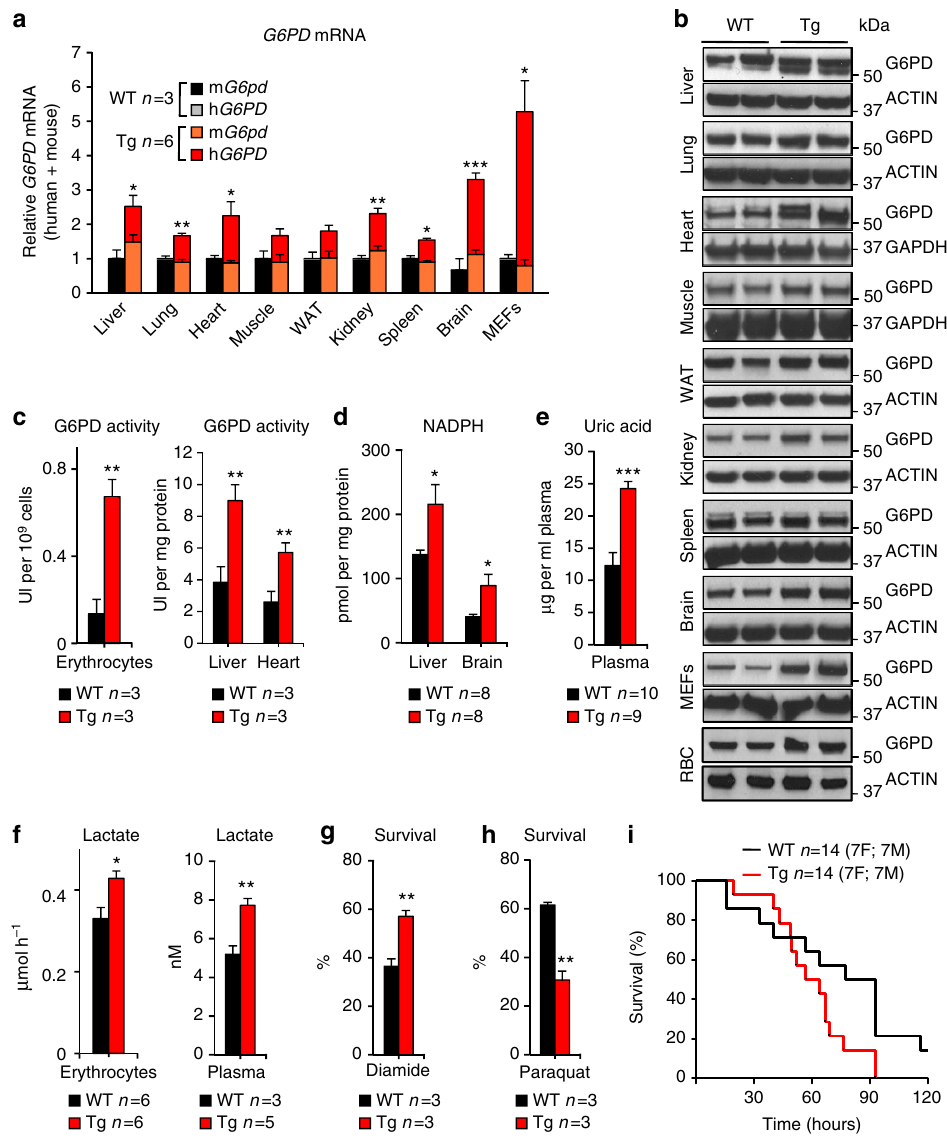
Figure 1 | Characterization of the G6PD-Tg mice. ( a ) Relative G6PD mRNA of the indicated tissues from mice 10–12 weeks old, one male and two females for the WTgroup, one male (M) and five females (F) in the Tg group. ( b ) Levels of G6PD protein in the indicated tissues from 3 to 4-months-old mice and mouse embryo fibroblasts (MEFs) where each lane corresponds to one individual animal for the tissues (WAT: white adipose tissue; RBC: red blood cells), or an independent MEF preparation for the MEFs. The anti-G6PD antibody reacts with both the mouse and human G6PD protein. In some tissues (liver, heart), a second upper band was also detected. ACTIN or GAPDH were used as loading controls. ( c ) G6PD enzymatic activity in the indicated samples. ( d ) Levels of NADPH in the indicated tissues. ( e ) Uric acid concentration in plasma. ( f ) Lactate production in isolated erythrocytes (left panel) and total levels of lactate in plasma (right panel). ( g , h ) Percentage of cell survival in G6PD-Tg and WT primary MEFs upon treatment with the oxidative stress inducers diamide ( g ) and paraquat ( h ). ( i ) Survival curve of mice treated with a lethal dose of paraquat. Bars represent the mean ± s.e.m. Statistic significance was assessed using the two-tailed Student’s t -test for all experiments, with the exception of i , where the logrank test was applied: * P o 0.05; ** P o 0.01; *** P o 0.001. and a slight reduction in fat mass, although the latter did not reach statistical significance (Supplementary Fig. 3b). Glucose intolerance and insulin resistance are associated to mouse ageing, and these processes are more pronounced in males compared to females. Interestingly, 1-year-old G6PD-Tg males were more glucose tolerant than their WT littermates, and presented (Fig. 2d,e). At 6 months of age, G6PD-Tg males were equal to not shown). In the case of females, glucose tolerance and insulin